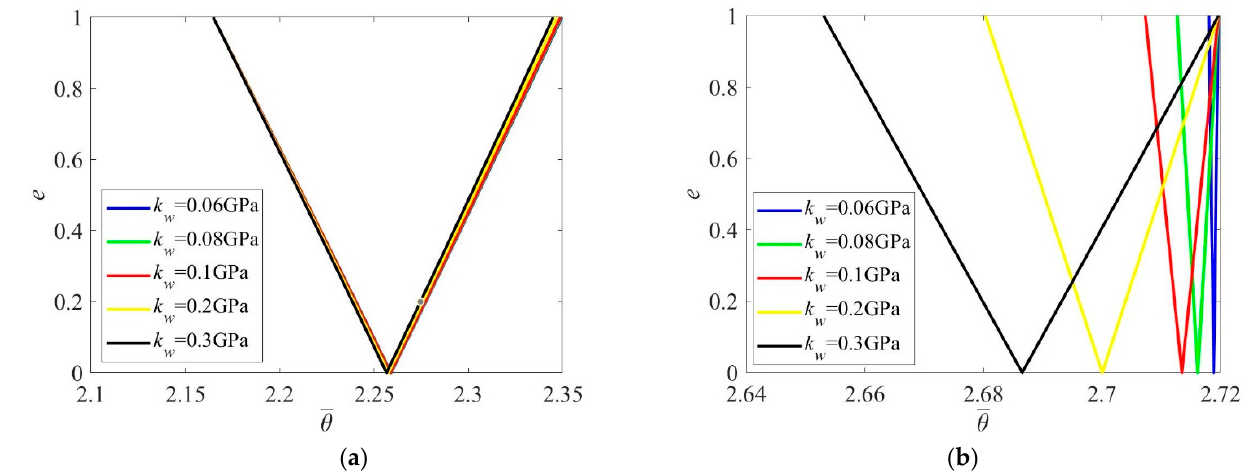
= θ L (cid:112) ρ / E ). ( a ) l = 5nm; ( b ) l =